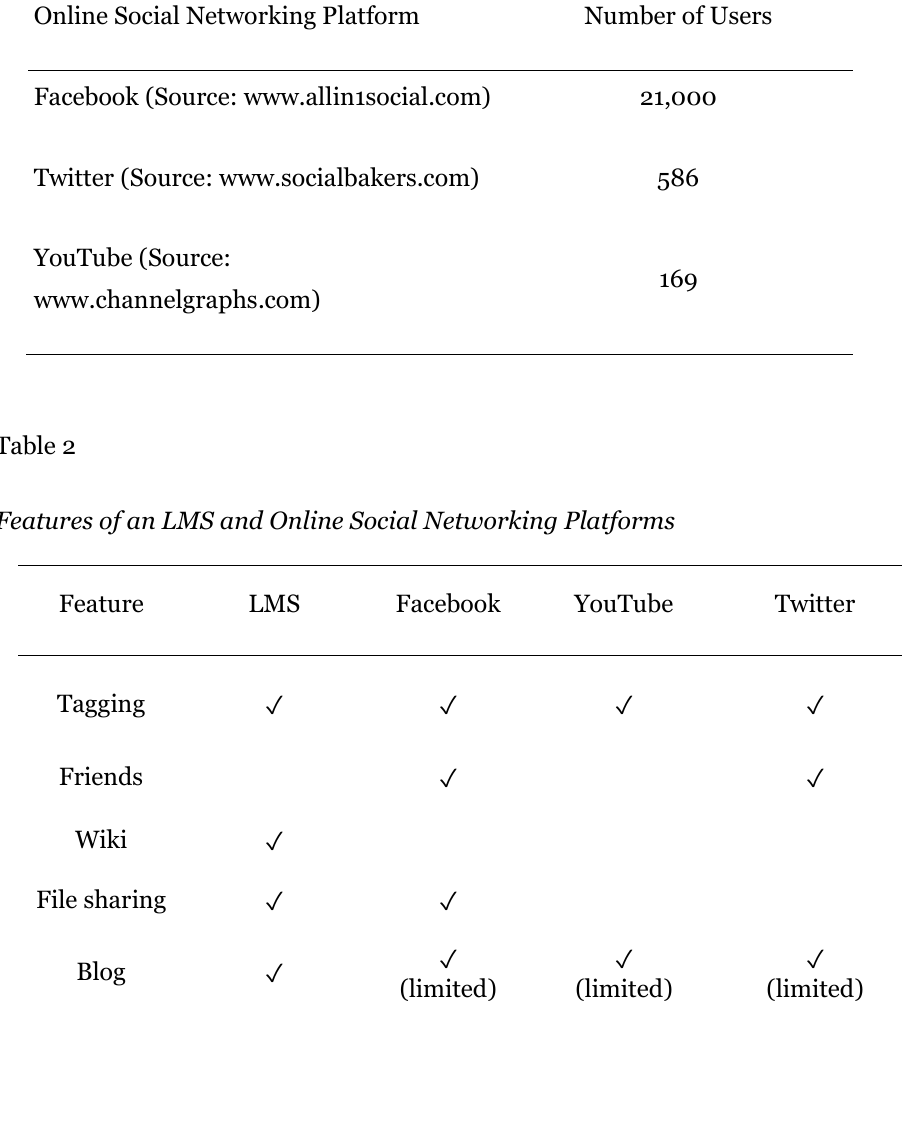
Online Social Networking Platform